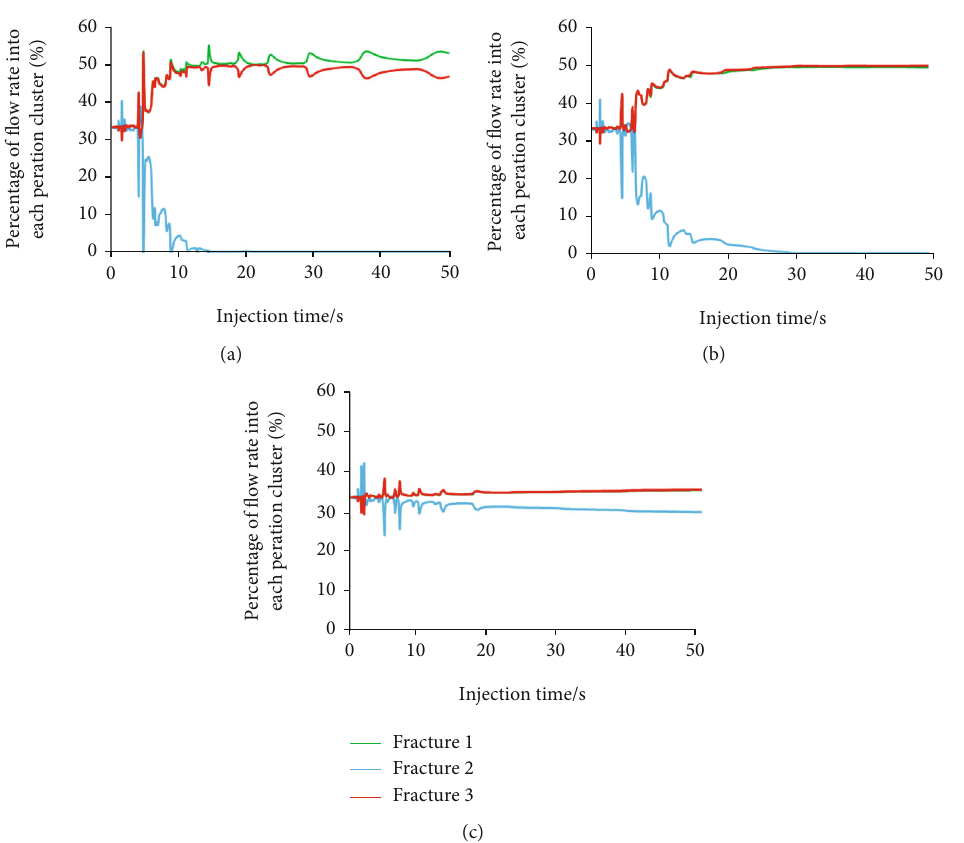
Figure 16: Percentage of fl ow into each cluster as a function of time for di ff erent perforation design parameters: (a) case 1; (b) case 4; (c) case